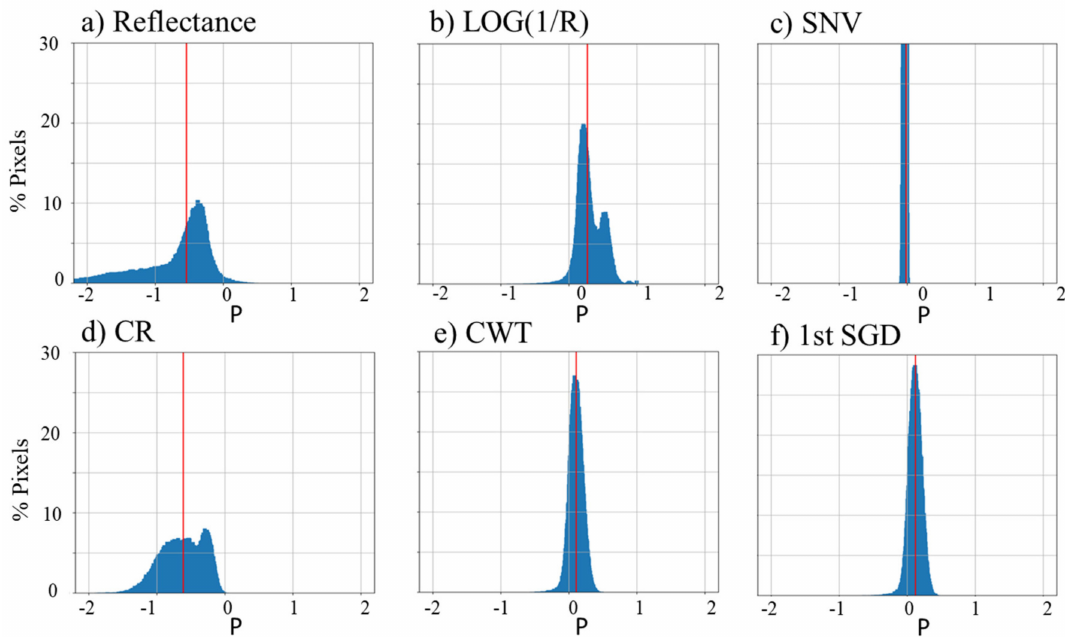
Figure 13. Histograms of parameter γ (non-linearity contribution of GBM) for MC